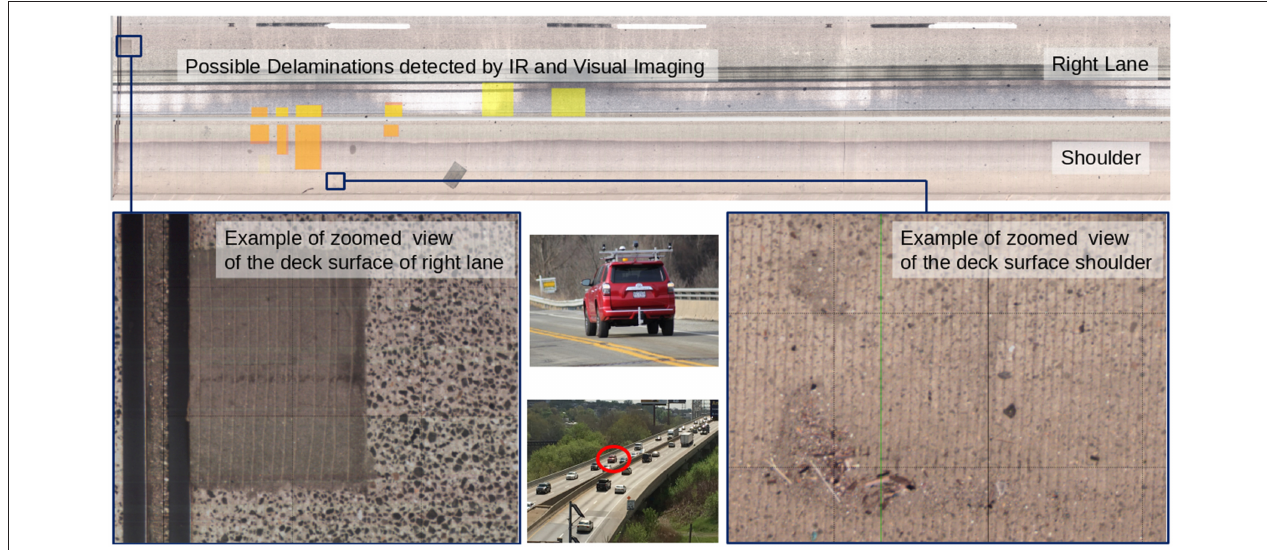
FIGURE 9 | High speed high resolution visual and infrared imaging of bridge deck (courtesy of